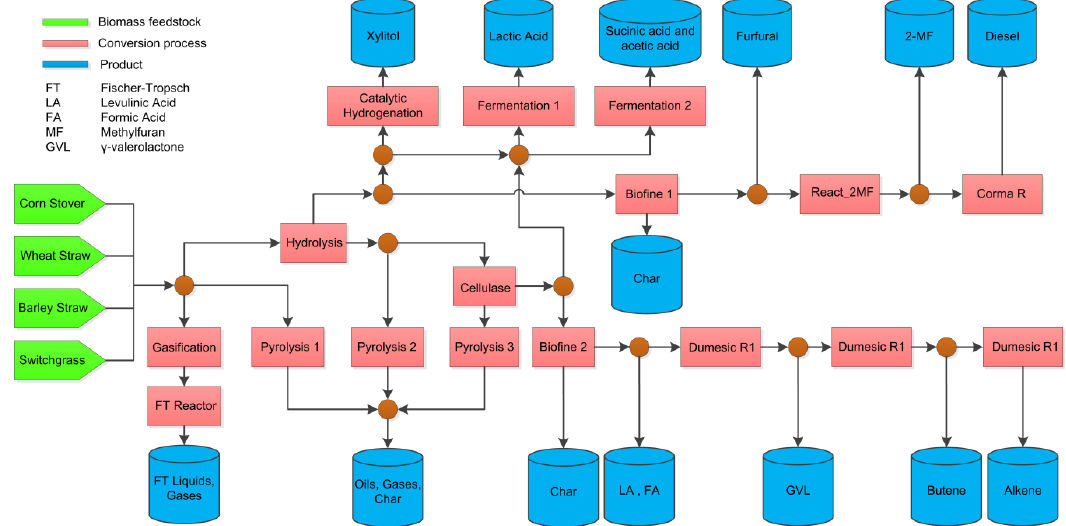
Figure 7. Biorefinery Superstructure with Multiple Feedstocks and Products, adapted from [43].